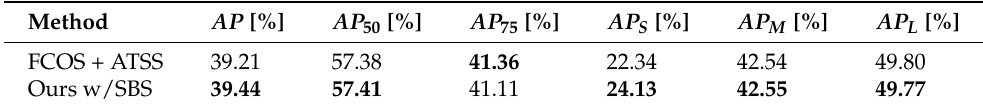
Table 1. Verification of the proposed Sample Balance Strategies (SBS) on MSCOCO minival set by comparing with the FCOS + ATSS